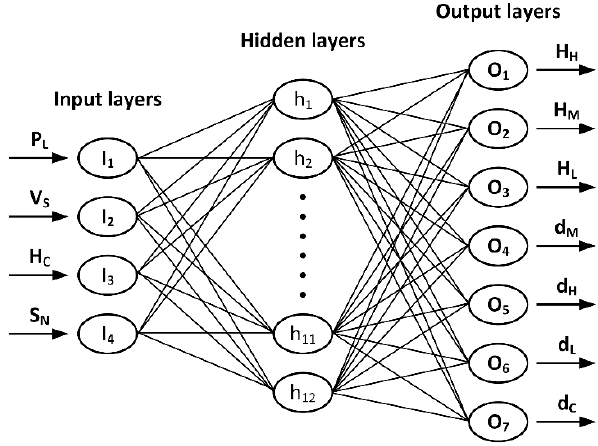
Figure 6. Geometrical technique for extracting attributes.